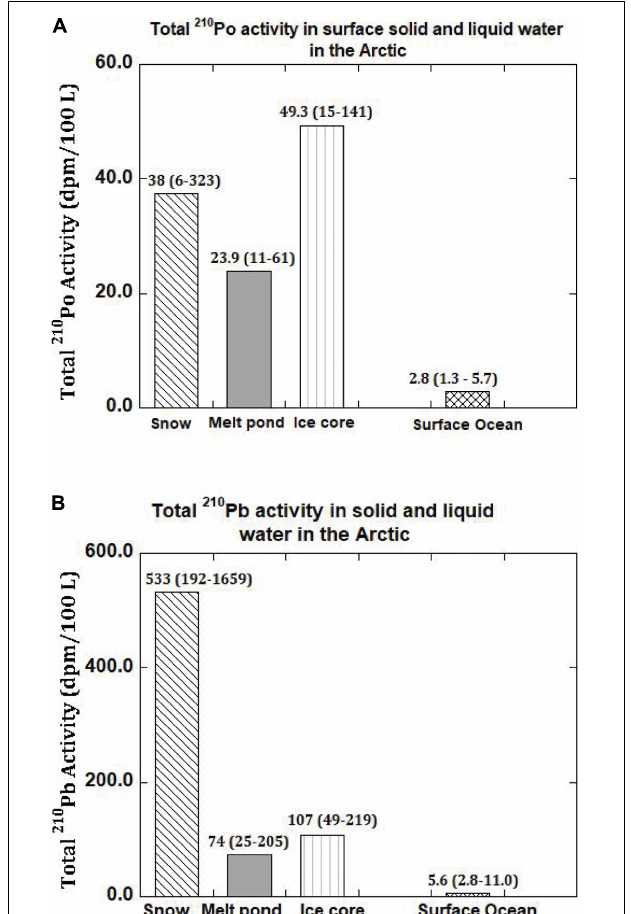
FIGURE 2 | (A) Activity of total (= particulate + dissolved) 210 Po and 210 Pb in snow, melt pond, ice core and surface ocean in the Arctic. The mean values are given and numbers in parenthesis denote the range (US GEOTRACES Arctic cruise, HLY 1502, R/V Icebreaker USCGC Healy). (B) Activity of total (= particulate + dissolved) 210 Pb and 210 Pb in snow, melt pond, ice core and surface ocean in the Arctic. The mean values are given and numbers in parenthesis denote the range (US GEOTRACES Arctic cruise, HLY 1502, R/V Icebreaker USCGC